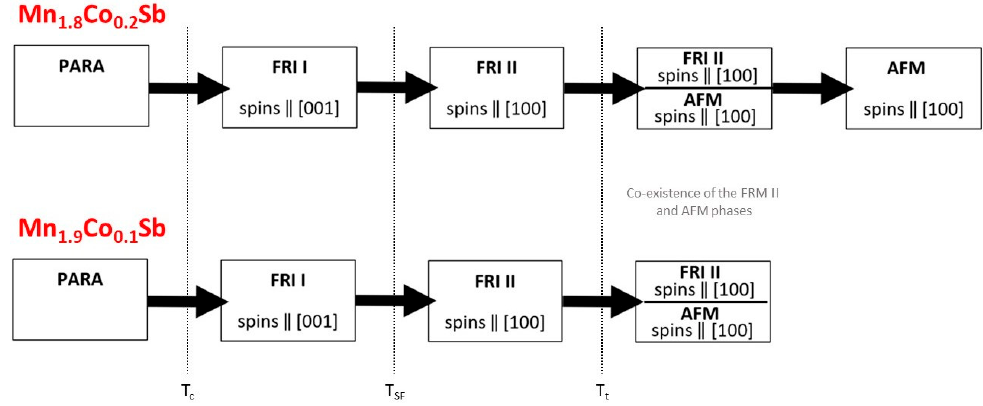
Figure 9. Sequence of magnetic phase transitions for Mn 1.8 Co 0.2 Sb and Mn 1.9 Co 0.1 Sb. Supplementary Materials: The following are available online at http://www.mdpi.com/2304-6740/6/4/113/s1, Figure S1: d M /d T curves for the cooling and heating cycles on Mn 1.8 Co 0.2 Sb; Figure S2: d M /d T curves for the cooling and heating cycles on Mn 1.85 Co 0.15 Sb; Figure S3: d M /d T curves for the cooling and heating cycles on Mn 1.9 Co 0.1 Sb; Figure S4: Spin flip transition temperatures T SF in Mn 2 − x Co x Sb compounds as a function of the Co content; Figure S5: Magnetic phase transition temperatures T t in Mn 2 − x Co x Sb compounds as a function of the Co content; Figure S6: Rietveld refinement of the neutron powder diffractogram of Mn 1.85 Co 0.15 Sb at 550 K; Figure S7: Rietveld refinement of the neutron powder diffractogram of Mn 1.9 Co 0.1 Sb at 550 K; Figure S8: Magnetic refinement of the neutron powder diffractogram of Mn 1.9 Co 0.1 Sb at 350 K; Figure S9: Magnetic refinement of the neutron powder diffractogram of Mn 1.9 Co 0.1 Sb at room temperature; Figure S10: Magnetic refinement of the neutron powder diffractogram of Mn 1.9 Co 0.1 Sb at 200K; Figure S11: Magnetic refinement of the neutron powder diffractogram of Mn Table S4: Lattice parameters, unit-cell volumes, and a / c ratios obtained from the x-ray powder diffractograms at RT; Table S5: a lattice parameters for each composition at different temperatures from the neutron data; Table S6: c lattice parameters for each composition at different temperatures from the neutron data; Table S7: Unit cell volumes for each composition at different temperatures from the neutron data; Table S8: z -coordinates from Rietveld refinements of the neutron powder diffractograms at five temperatures (550 K, 350 K, RT, 200 K, 50 K) for x = 0.2 and x = 0.1; Table S9: Isotropic thermal displacement parameters U iso from neutron powder diffraction at five temperatures (550 K, 350 K, RT, 200 K, 50 K) for x = 0.2 and x = 0.1; Table S10: Co occupancy on the Mn1 site at 550 K—stoichiometric vs. refined values; Table S11: Final agreement factors of the magnetic structure refinements for the Mn 1.9 Co 0.1 Sb (350K, RT, 200 K, 50 K) neutron powder